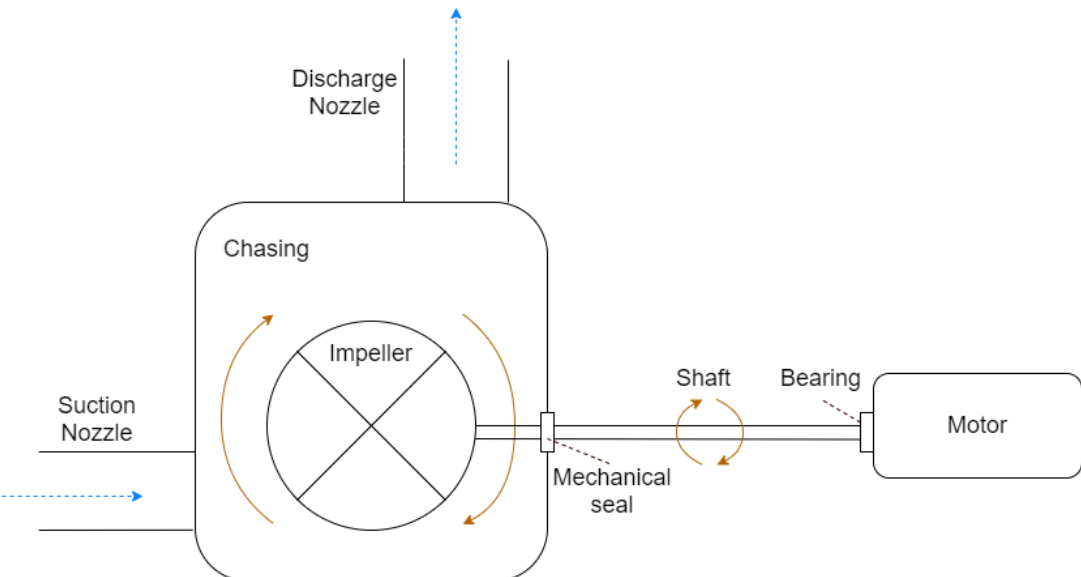
Figure 6. A simple figure of a centrifugal pump. From left to right; water enters the impeller through the suction nozzle, where kinetic energy will be applied to the liquid through turning of the shaft. The chasing keeps the water within the system, while the mechanical seals make sure there is no leakage. The bearing reduces the friction between the moving and stationary parts and is found in several places within a pumping system. The water exits at the discharge